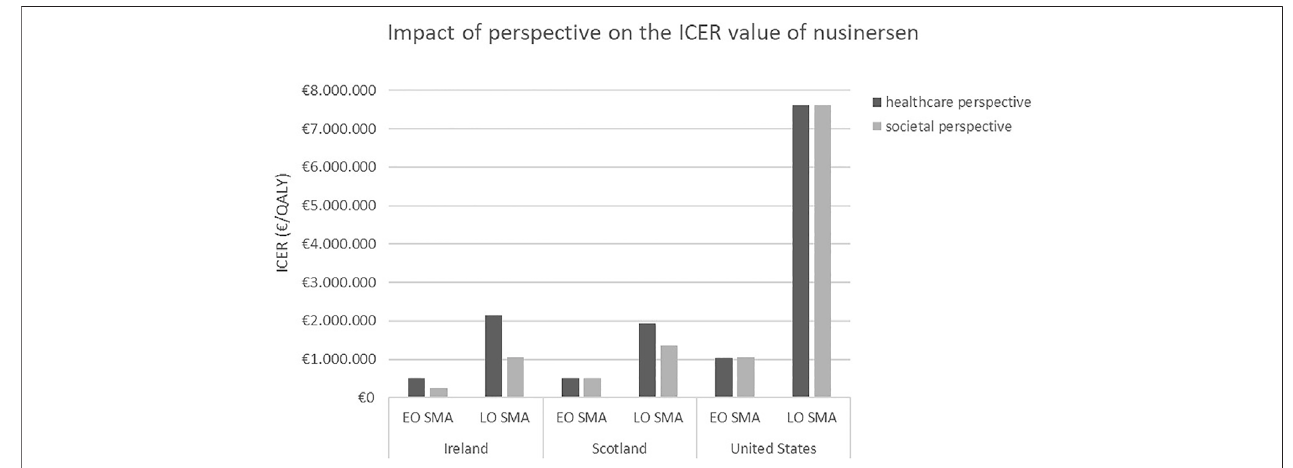
FIGURE 1 | ICER values of nusinersen for EO and LO SMA, depending on the chosen perspective, reported by HTA agencies in Ireland, Scotland, and the US. Abbreviations: ICER, incremental cost-effectiveness ratio; EO, early-onset; LO, later-onset; SMA, spinal muscular atrophy.